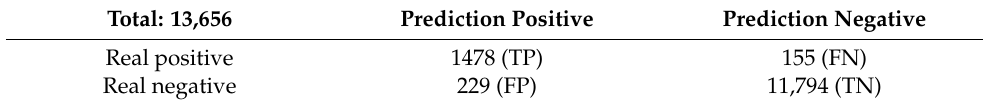
Table 3. Confusion matrix of virtual keyboard experiment.